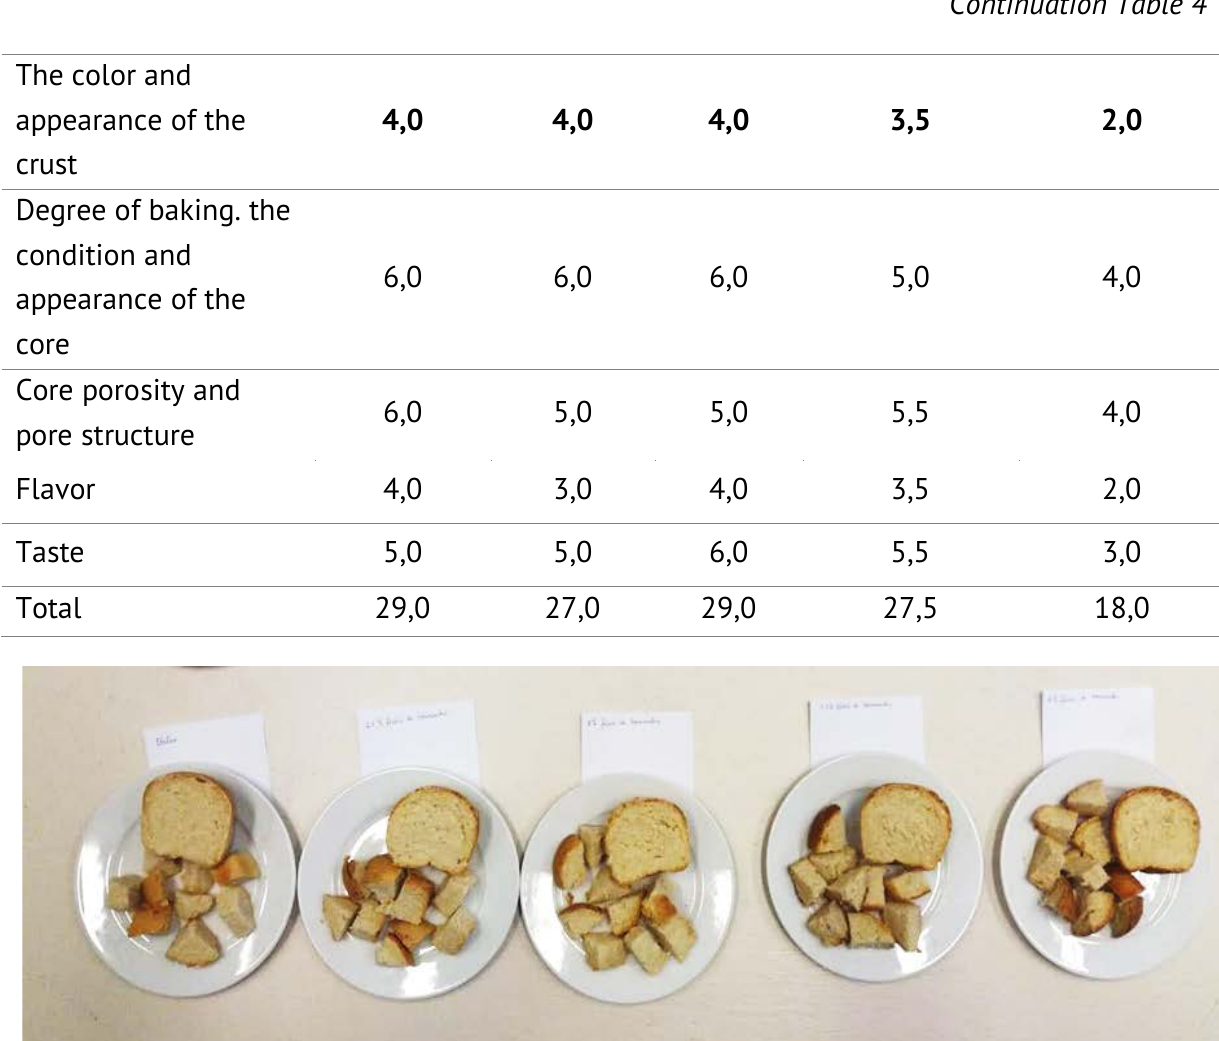
Figure 8. Organoleptic evaluation of bread quality with the addition of Jerusalem artichoke